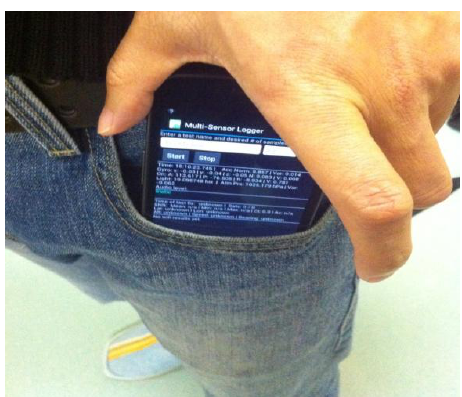
Figure 7. The phone in pants pocket.